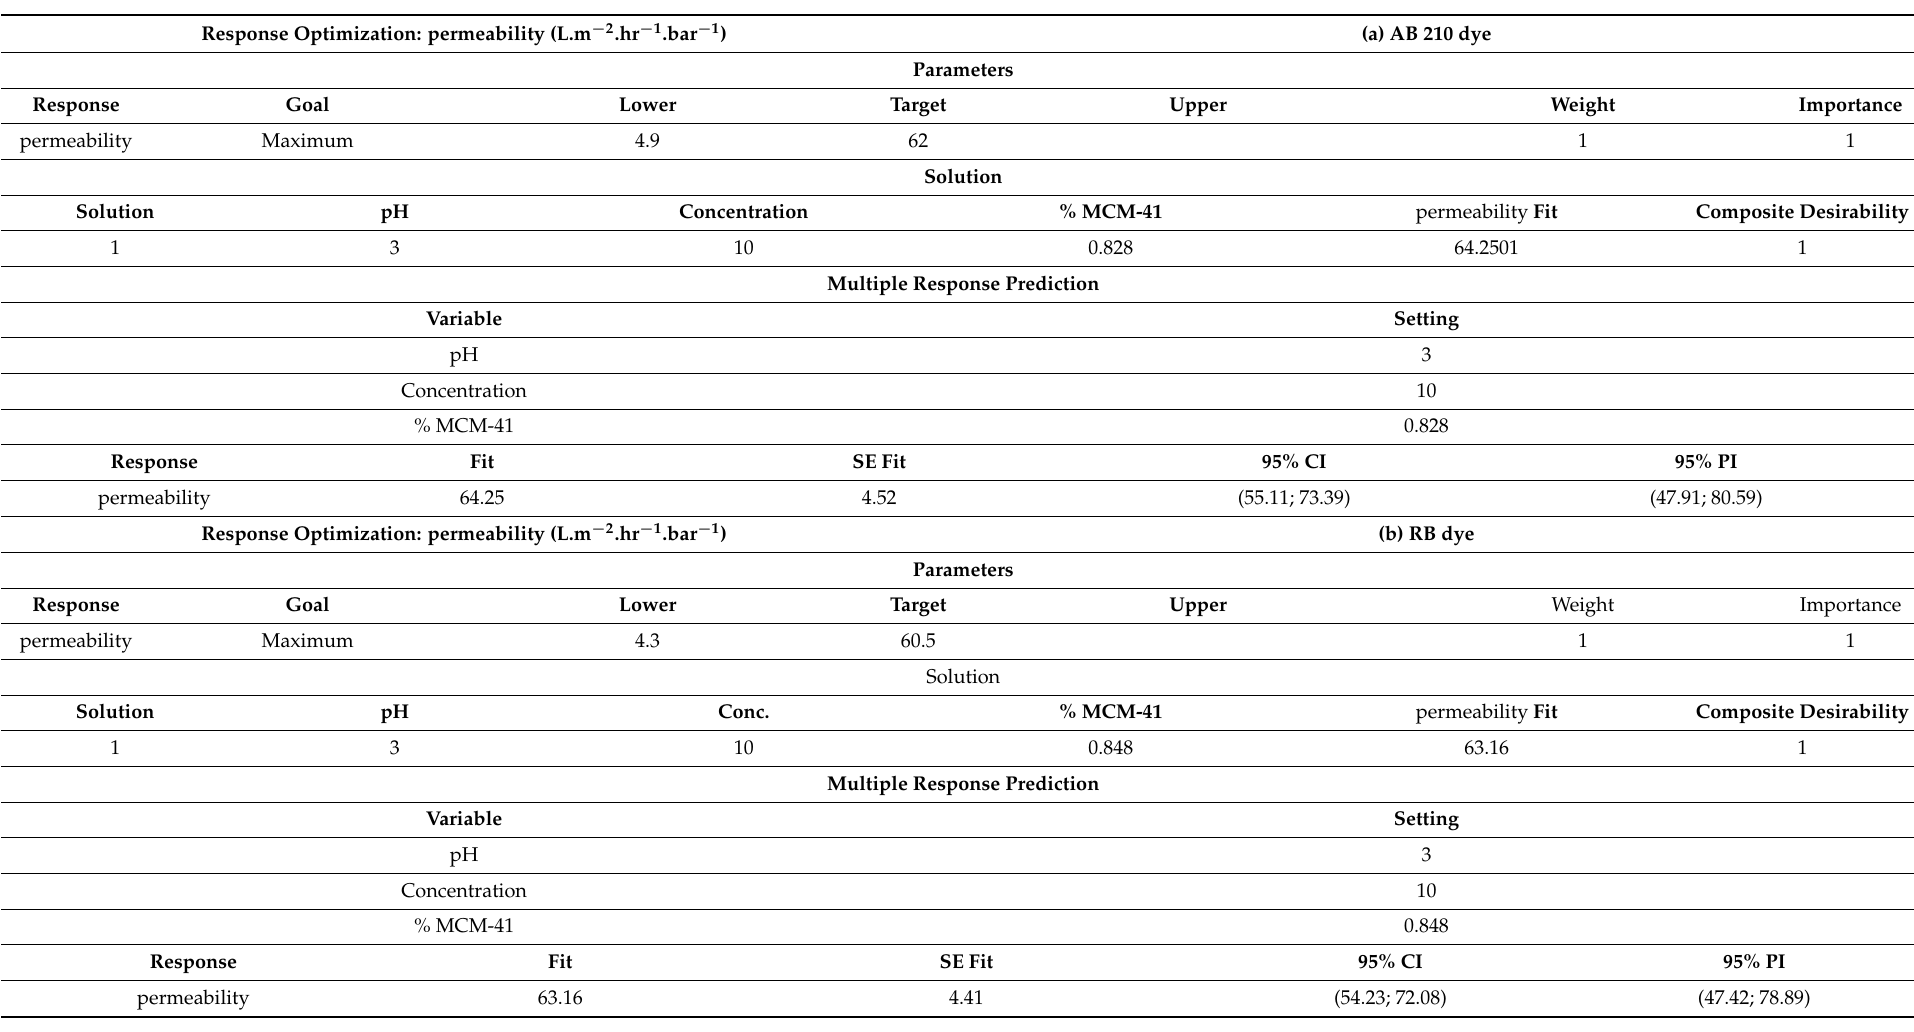
Table 6. Predicted response for the membrane permeability of (a) AB-210, and (b) RB